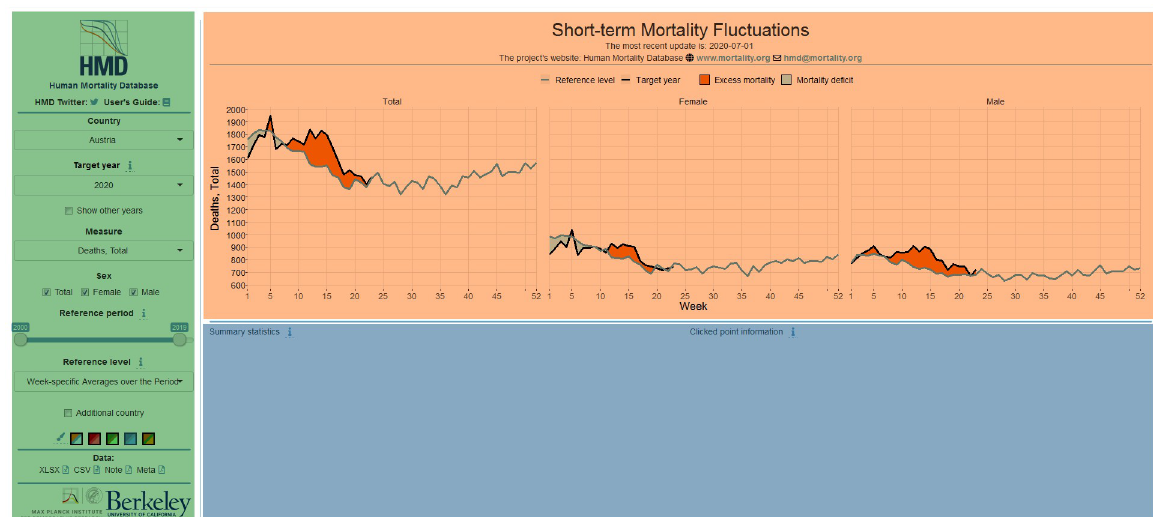
Fig 1. The interface of the visualization tool. The sidebar (indicated by green) contains the user input variables and links to the data source. The main figure appears in the area designated by orange color and summary statistical information is shown below the graphics in the blue area after user